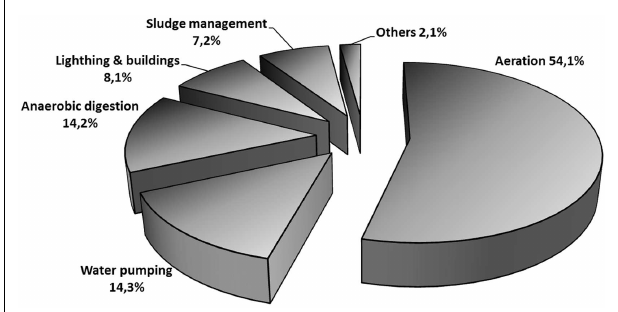
FIGURE 3 |Typical energy requirements in a conventional domestic wastewater treatment plant . Derived from data fromWater Environment Federation